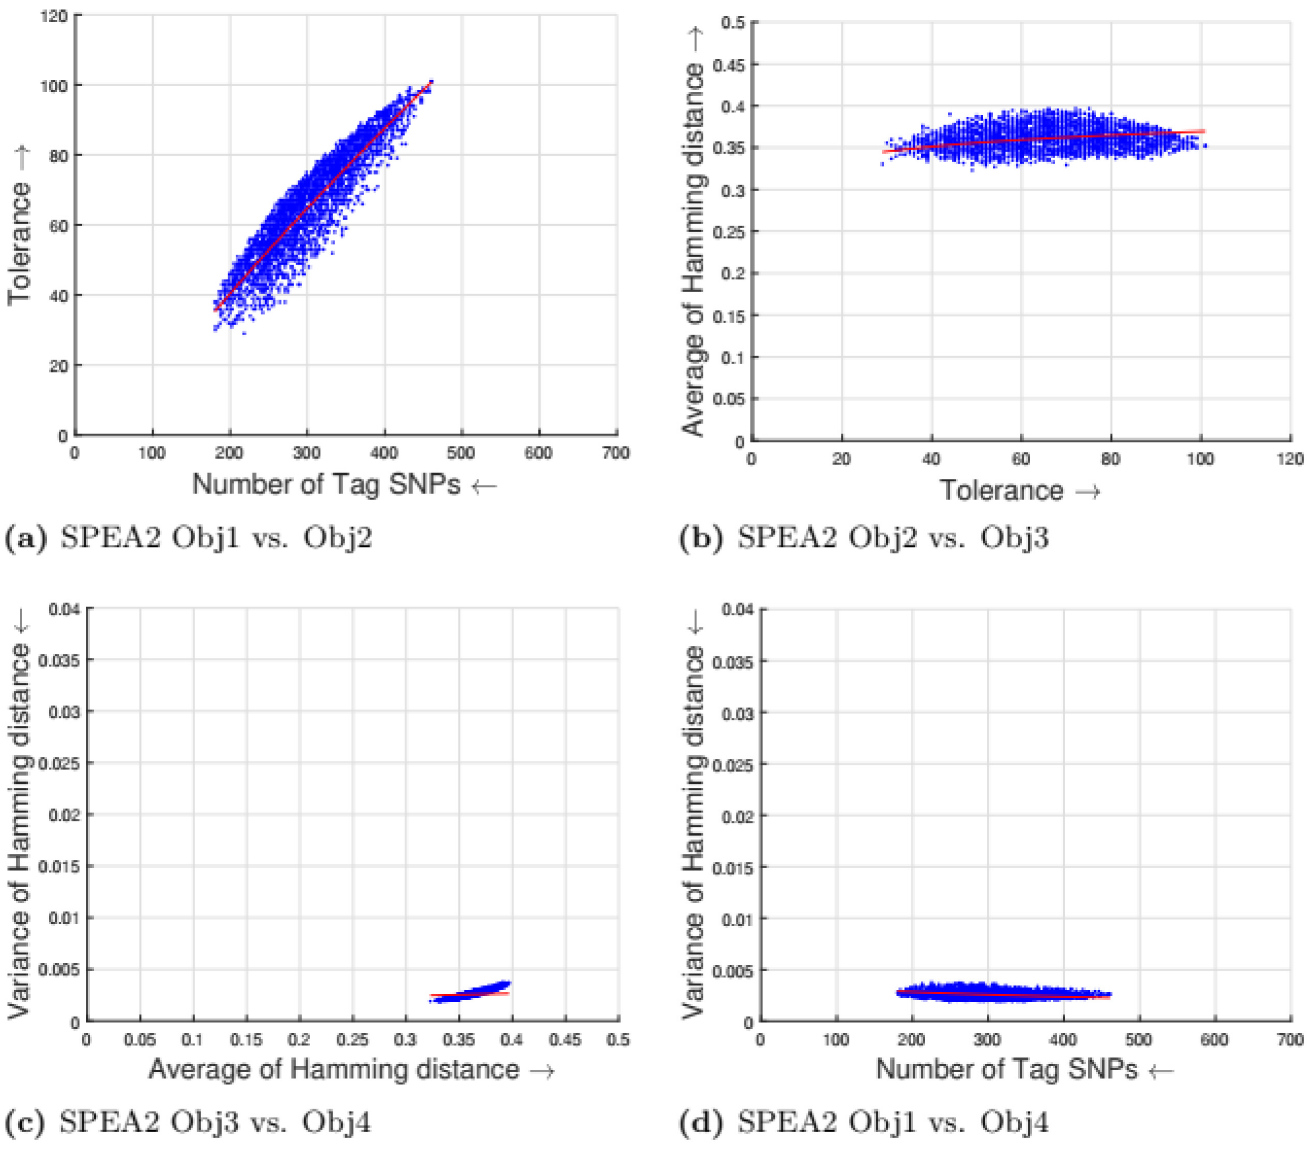
Fig 2. Experimental results of SPEA2 for the tag SNPs selection using random initialization. Obj1 stands for the number of tag SNPs, Obj2 is the tolerance for missing data, Obj3 measures the average Hamming distance between alleles, and Obj4 controls the variance of detection power in each allele. (a) SPEA2 obj1 vs. Obj2, (b) SPEA2 Obj2 vs. Obj3, (c) SPEA2 Obj3 vs. Obj4, (d) SPEA2 Obj1 vs. Obj4.